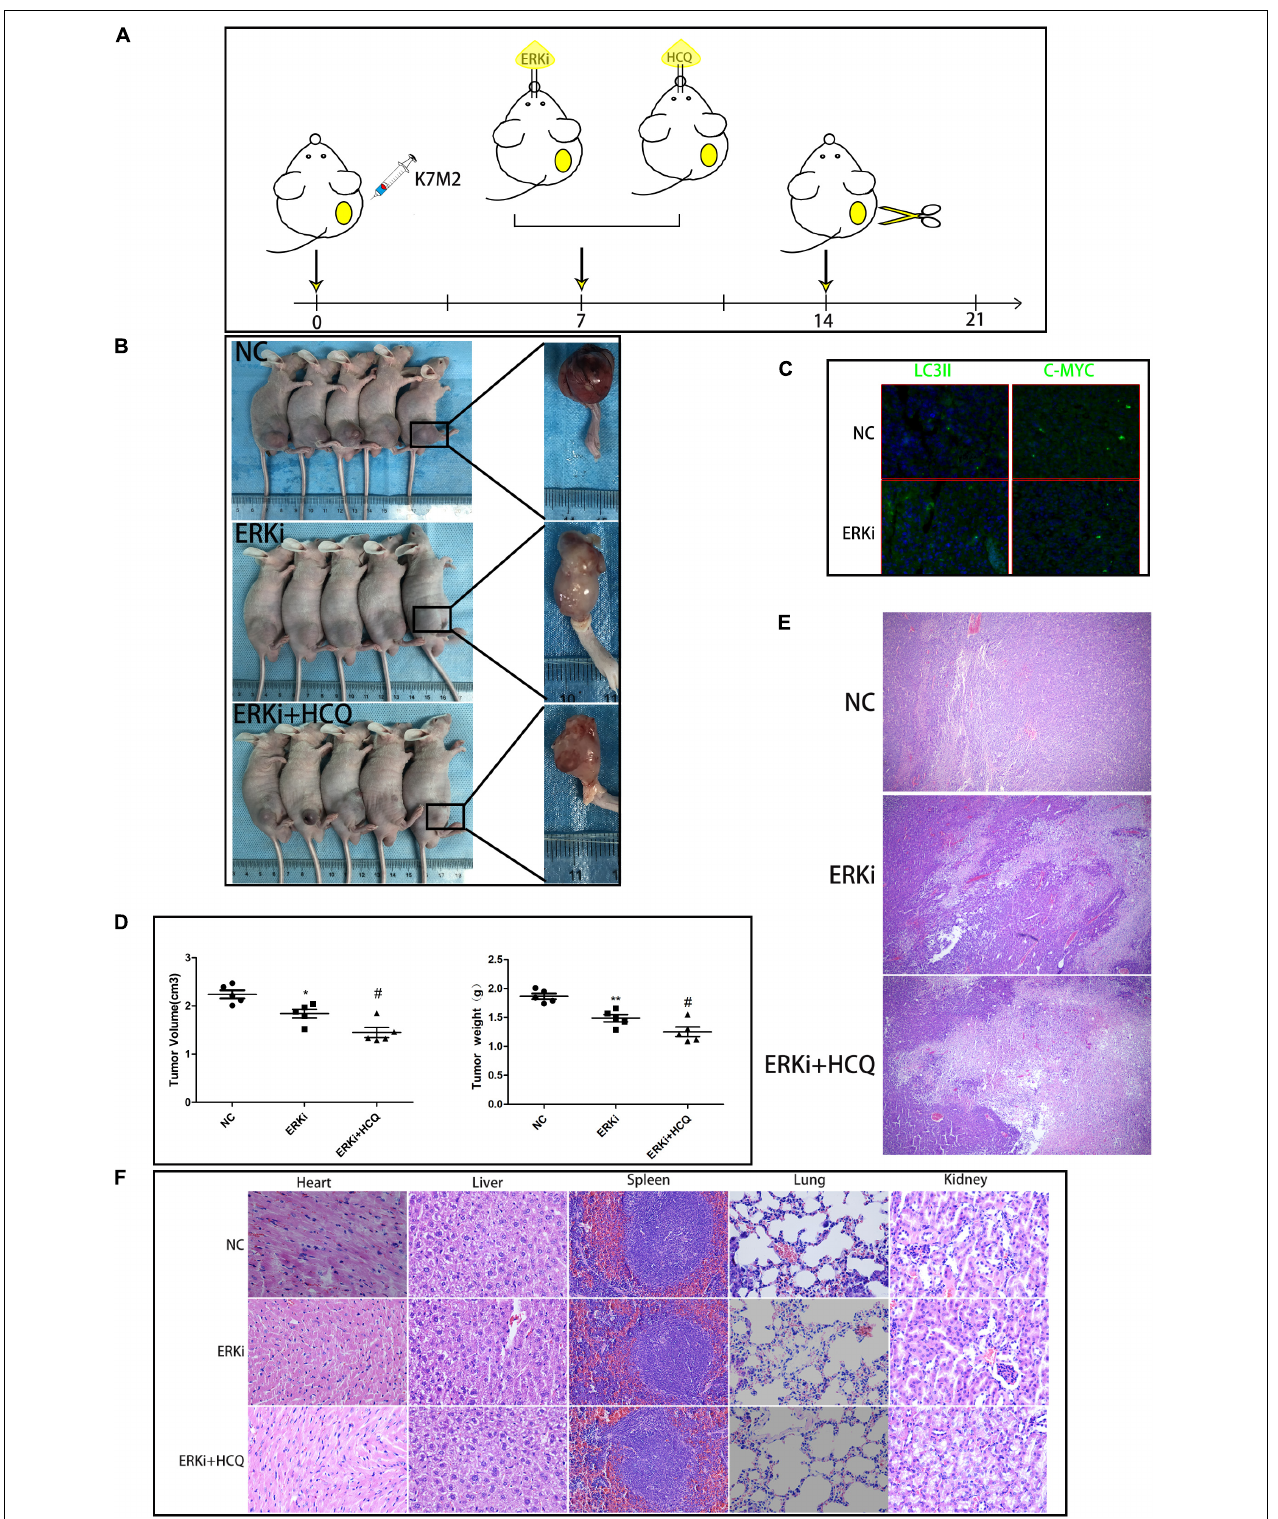
FIGURE 7 | Synergistic inhibitory effect of ERKi and HCQ combined treatment on OS in vivo . (A) Schematic representation of treatment regimen and surgery. (B,D) Tumor formation in different groups. (C) Immunofluorescence staining to determine the levels of LC3B and CMYC. (E) H&E staining of OS tissue among groups. (F) H&E staining of organ tissues of mice administered ERKi or HCQ ( n = 5 per group; **p < 0.01 versus NC group; *p < 0.05 versus NC group; # p < 0.05 versus ERKi group).